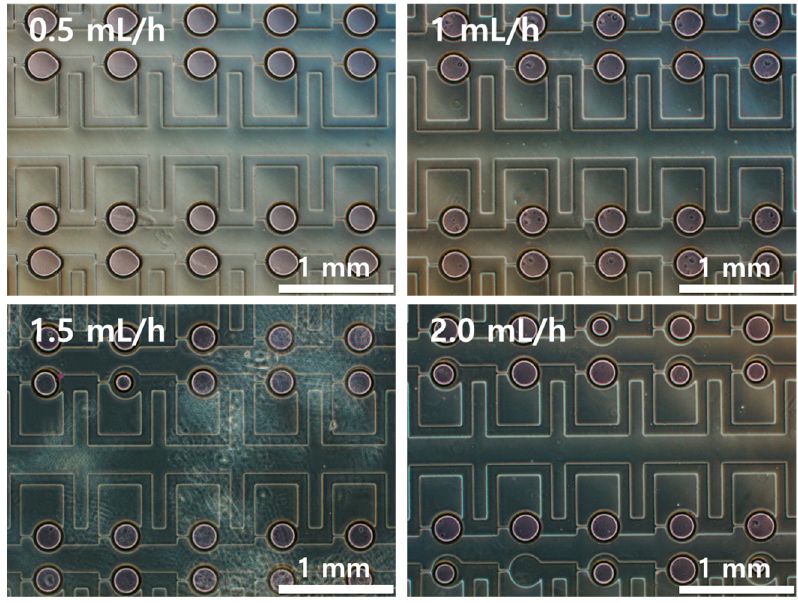
Figure 5. Optical images of arrayed sample in parallel microfluidic device at various flow rates.